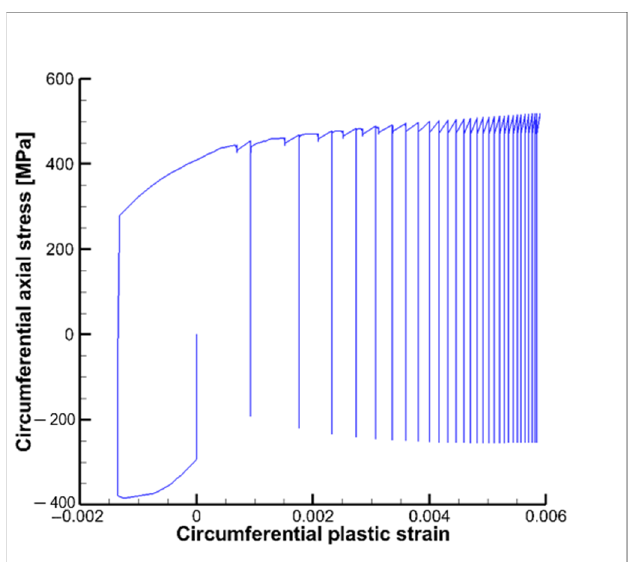
Figure 15. Circumferential stress vs. circumferential plastic strain.